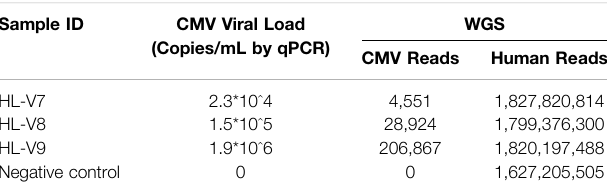
TABLE 2 | The results of WGS for three samples with known human CMV infection. Sample